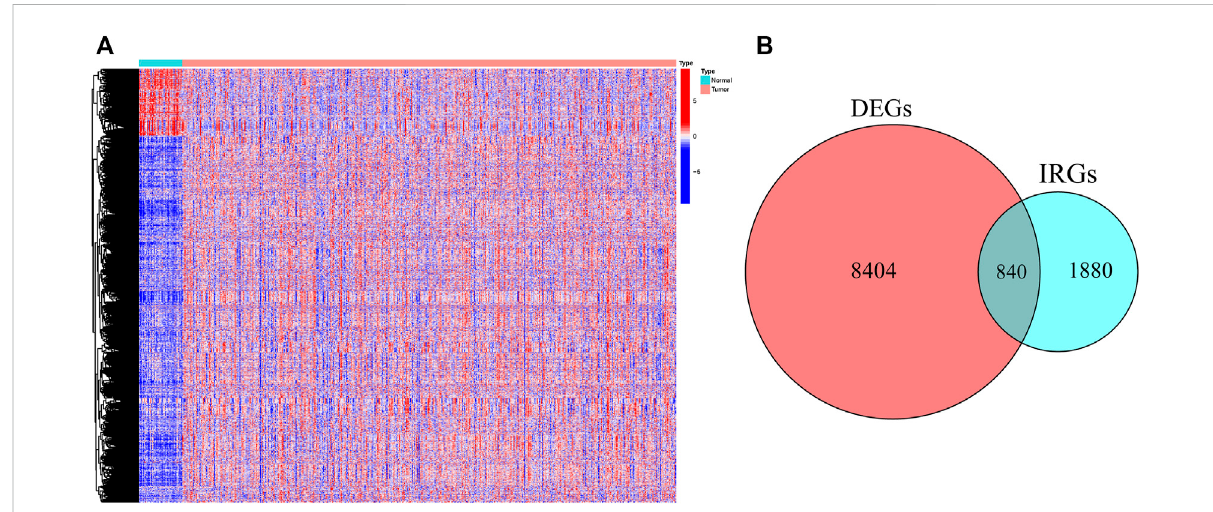
FIGURE 4 The heatmap (A) and Venn diagram (B) identi fi ed the differentially expressed genes (DEGs) and immune-related DEGs between tumor and normal samples in